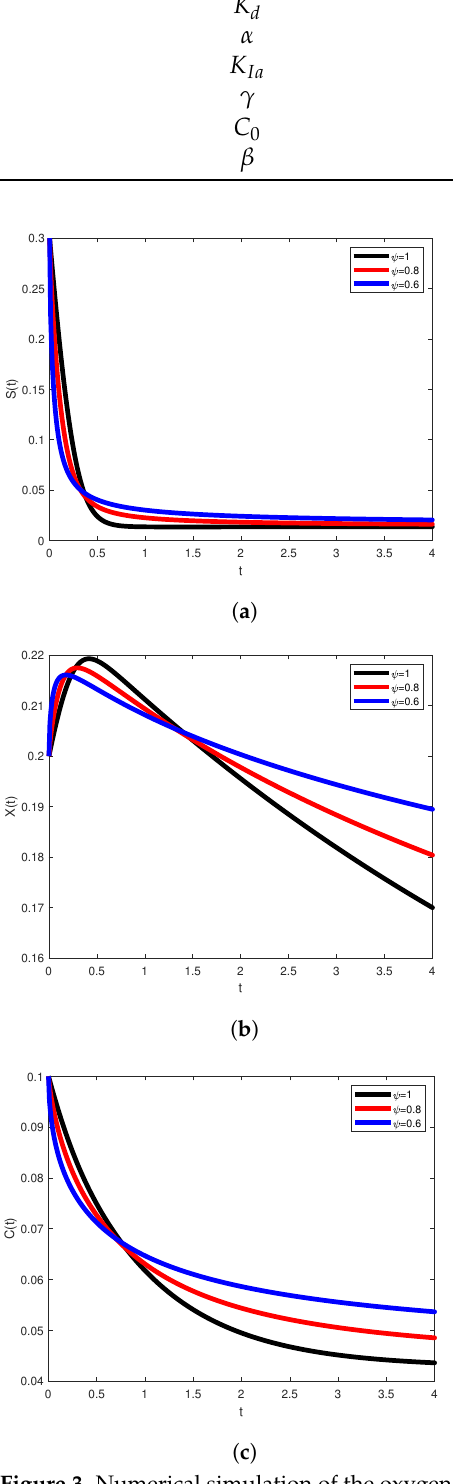
Figure 3. Numerical simulation of the oxygen saturation concentration, the substrate concentration, and the microorganism concentration for different values of fractional order. The value of the parameters is stated in Table 1. ( a ) Dynamic of the concentration of substrate. ( b ) Dynamic of the substrate concentration. ( c ) Dynamic of the microorganism